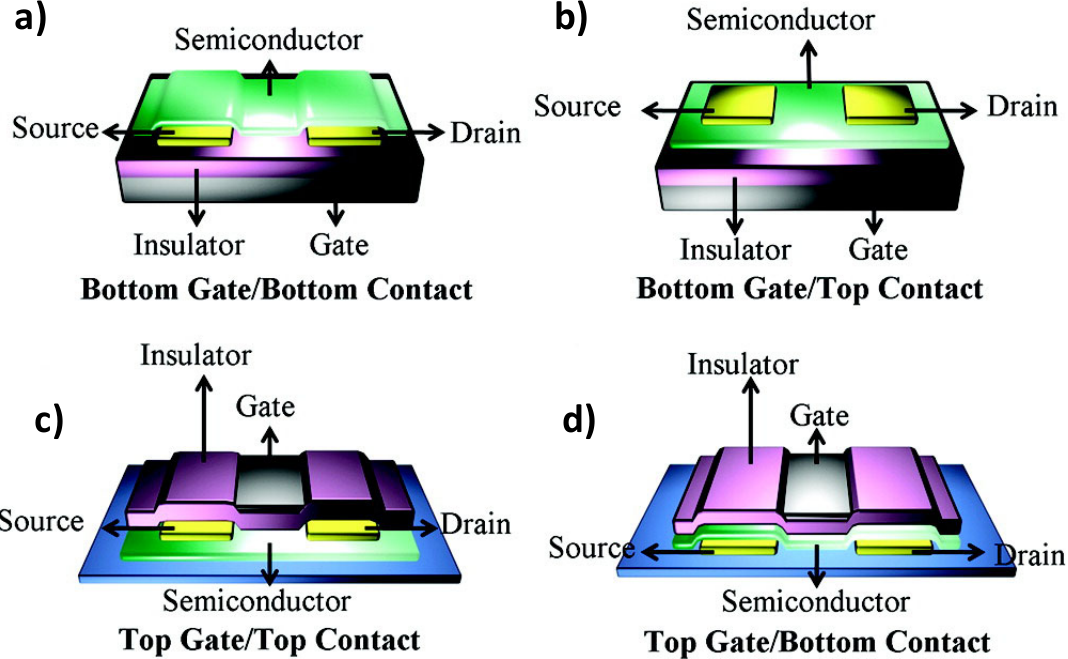
Figure 1. Four types of OFET device structure: ( a ) bottom gate/bottom contact; ( b ) bottom gate/top contact; ( c ) top gate/top contact; and ( d ) top gate/bottom contact. Reprinted with permission from Ref. [40]. Copyright (2012) American Chemical Society.